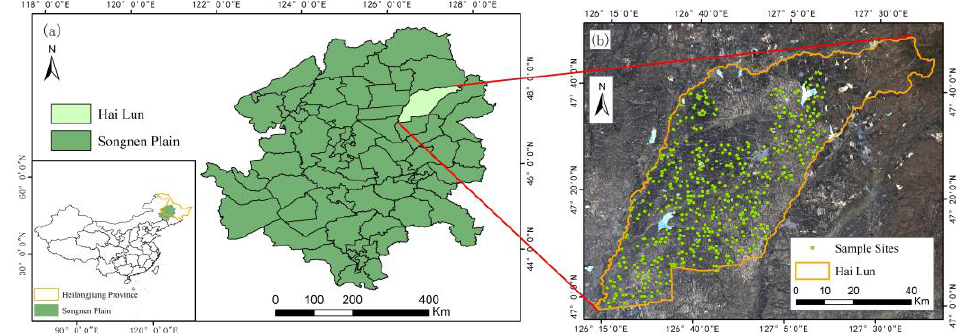
Figure 1. ( a ) The location of study area (Hai Lun) in Songnen Plain and the positions of Songnen Plain and Heilongjiang Province in China, and ( b ) the position of sampling sites (496) in study area with Landsat 8 OLI image after true color compositing by bands 4 (red), 3 (green), 2 (blue).